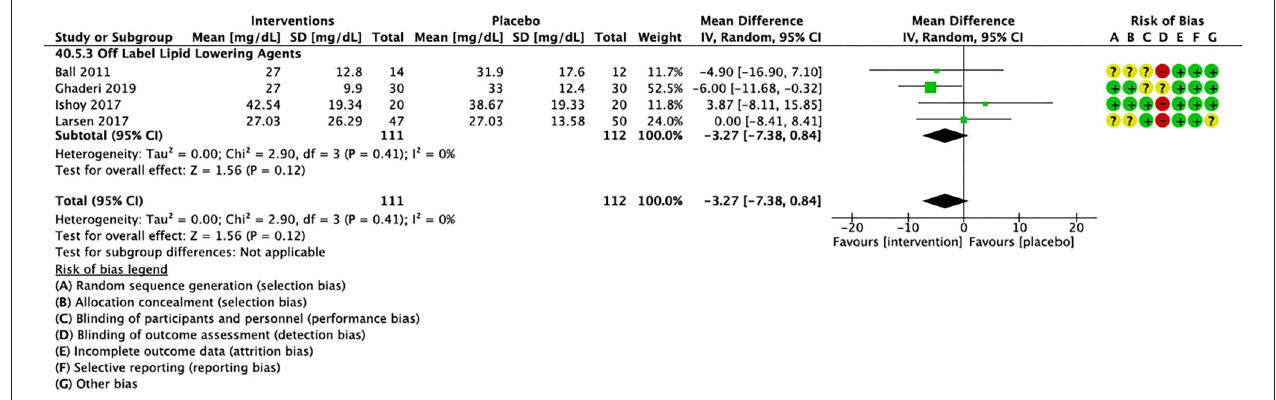
FIGURE 5 | Forest plot showing the pooled mean difference in changes in very low-density lipoprotein cholesterol (mg/dL) for all interventions as compared to placebo and Risk of Bias assessments.